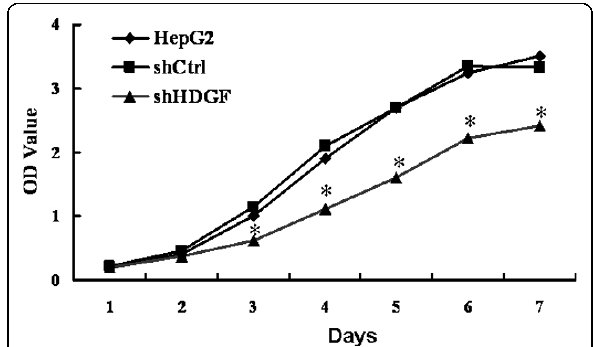
Figure 3 Down-regulation of HDGF inhibited cell growth . The cell growth of parental HepG2 cells and their stable derivatives, shCtrl and shHDGF, were examined by MTT assay over a seven-day period. * P < 0.05, as compared to parental HepG2 cells and shCtrl cells.